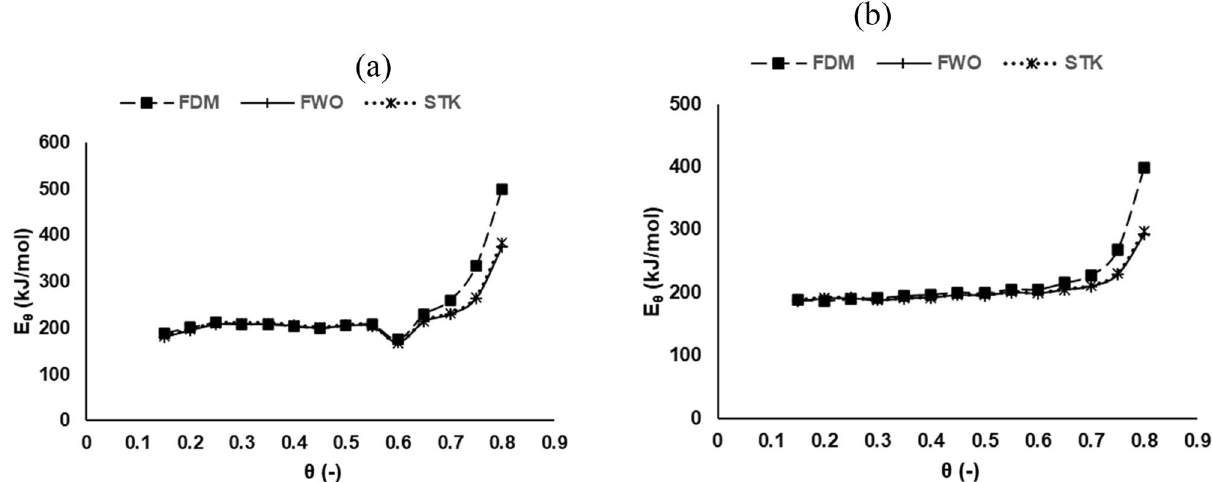
Figure 5. Plots of apparent activation energy, E θ , against conversion ratio, θ, ( a ) MH and ( b ) RP in a pyrolytic environment.